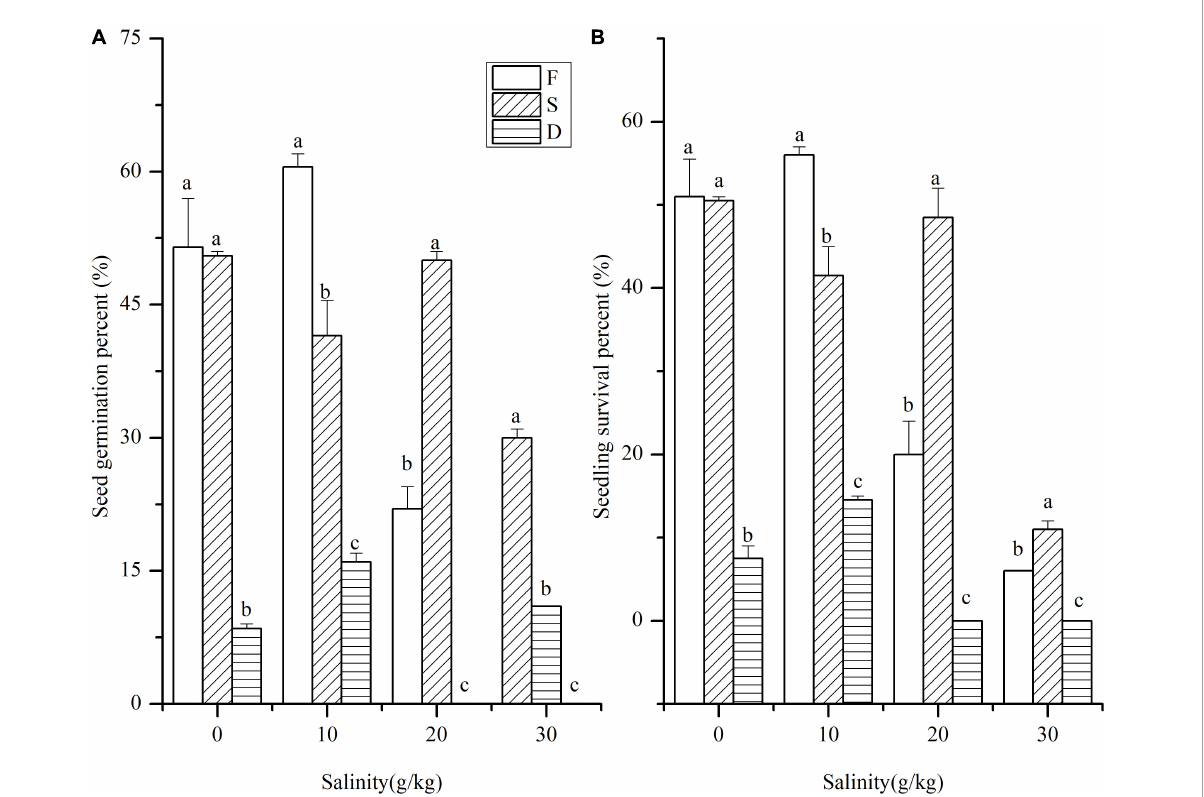
FIGURE2 Seed germination of S. salsa subjected to salt and water treatments. (A) Seed germination percent and (B) seedling survival percent subjected to water and salt treatment (long-term flooding (5–15 cm, F), periodic flooding (0–10 cm, S), and long-term drought (drought to saturated, D). Different letters indicate significant differences in different water treatments at the same salinity. The data was 0 at D treatment in salinity values of 20 and 30